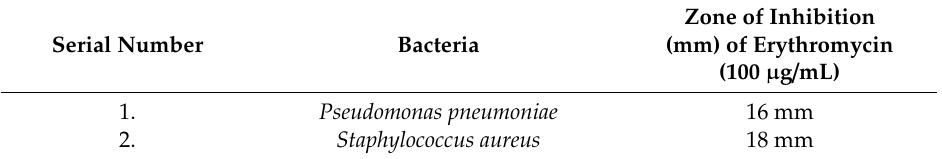
Table 3. Zones of inhibition (ZOIs) of antimicrobial activity of erythromycin for bacterial species.